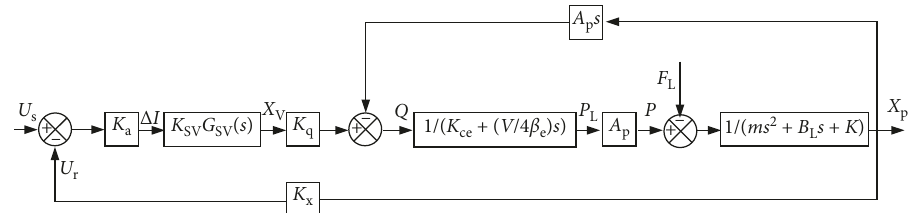
Figure 3: Transfer function block diagram of the position control system.